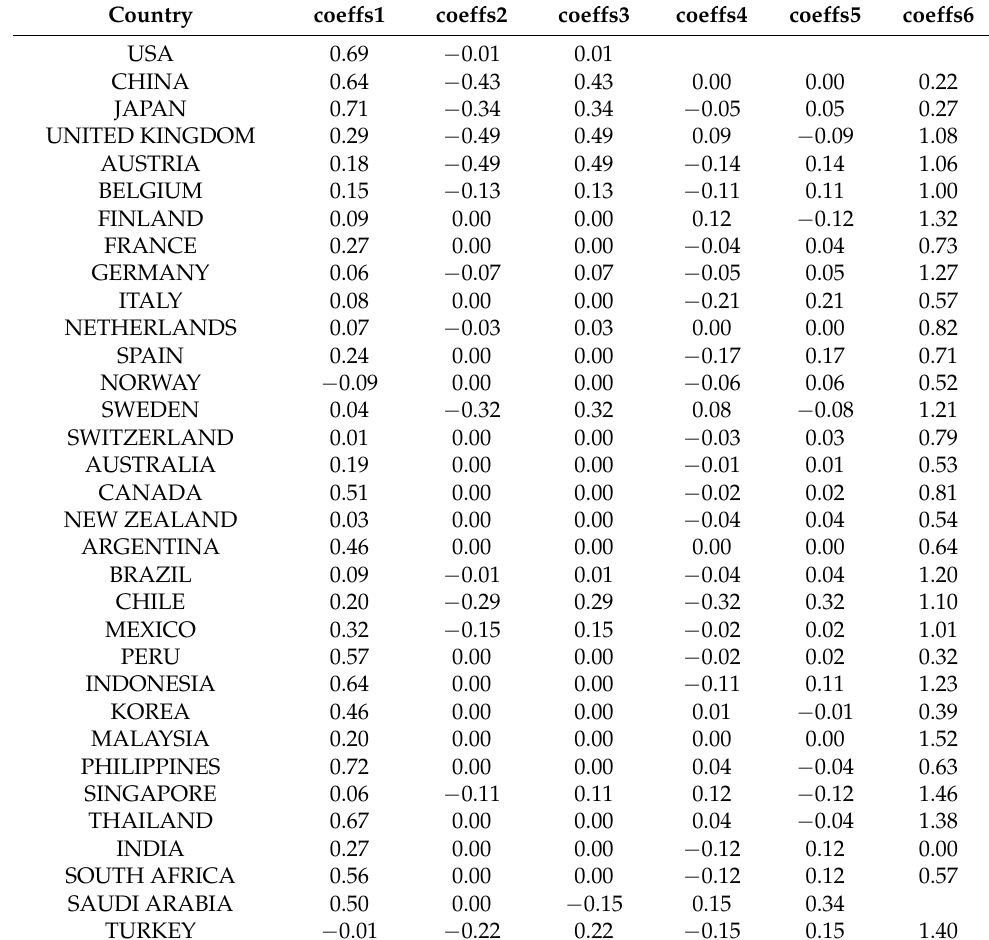
Table A9. IS Curve-DSGE-GVAR.